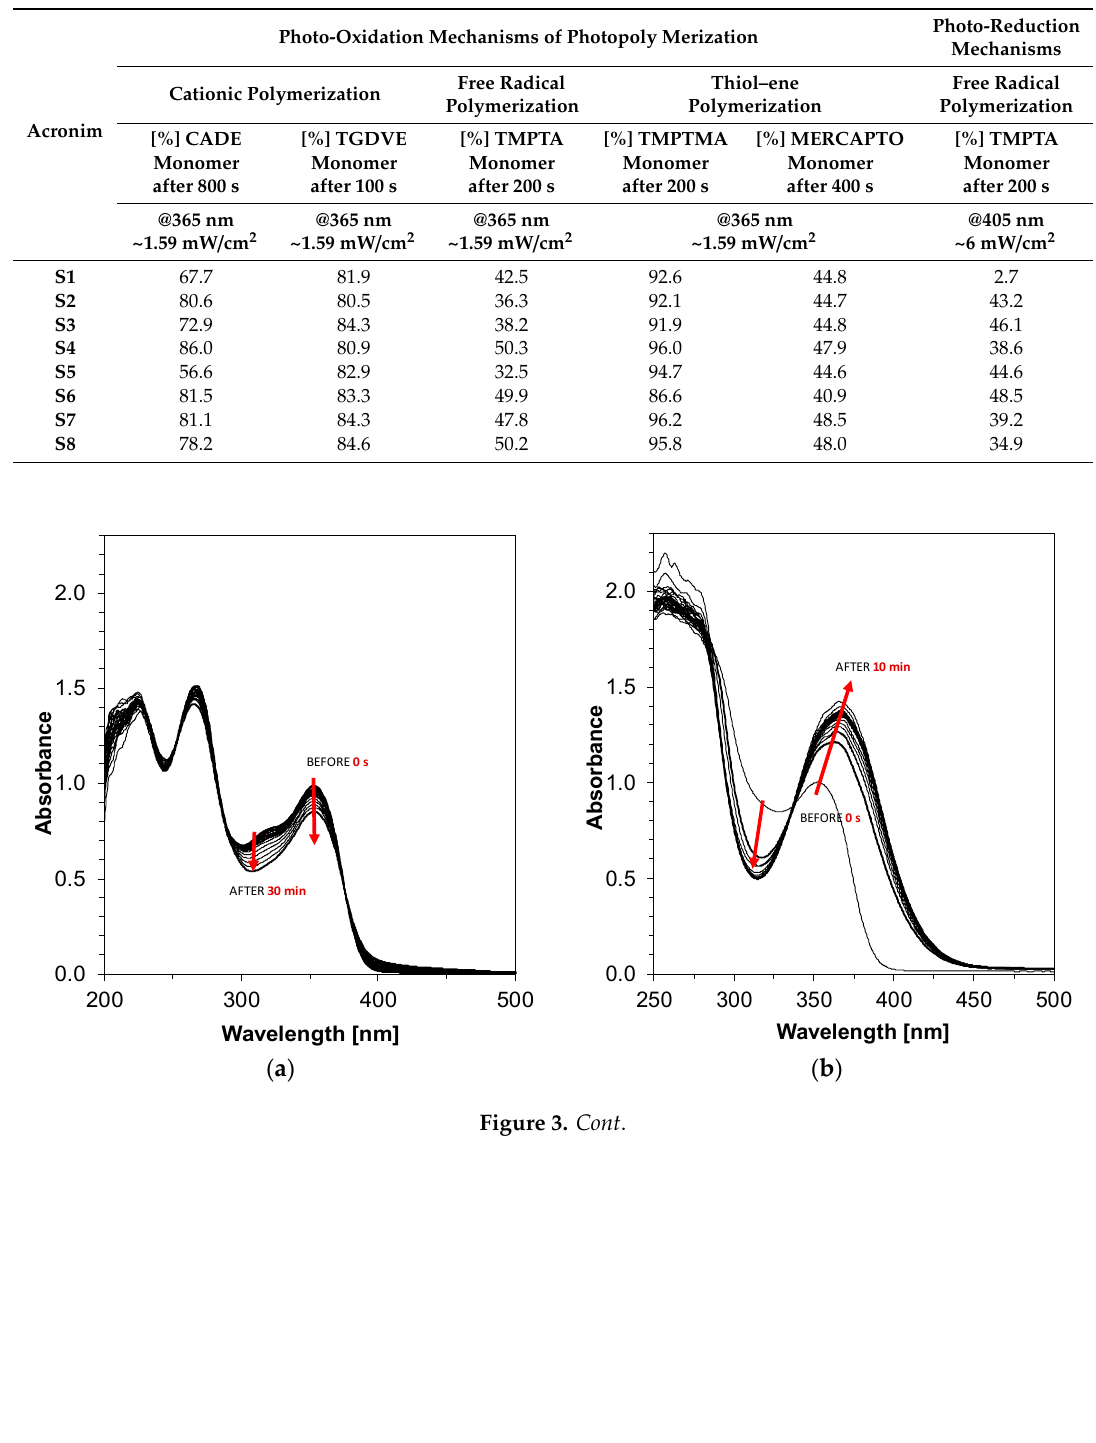
Table 3. Functional group conversions using bimolecular photoinitiating systems. (A) Photo-oxidation mechanisms of photopolymerization: diphenyliodonium hexafluorophosphate (HIP 1 wt.%) and